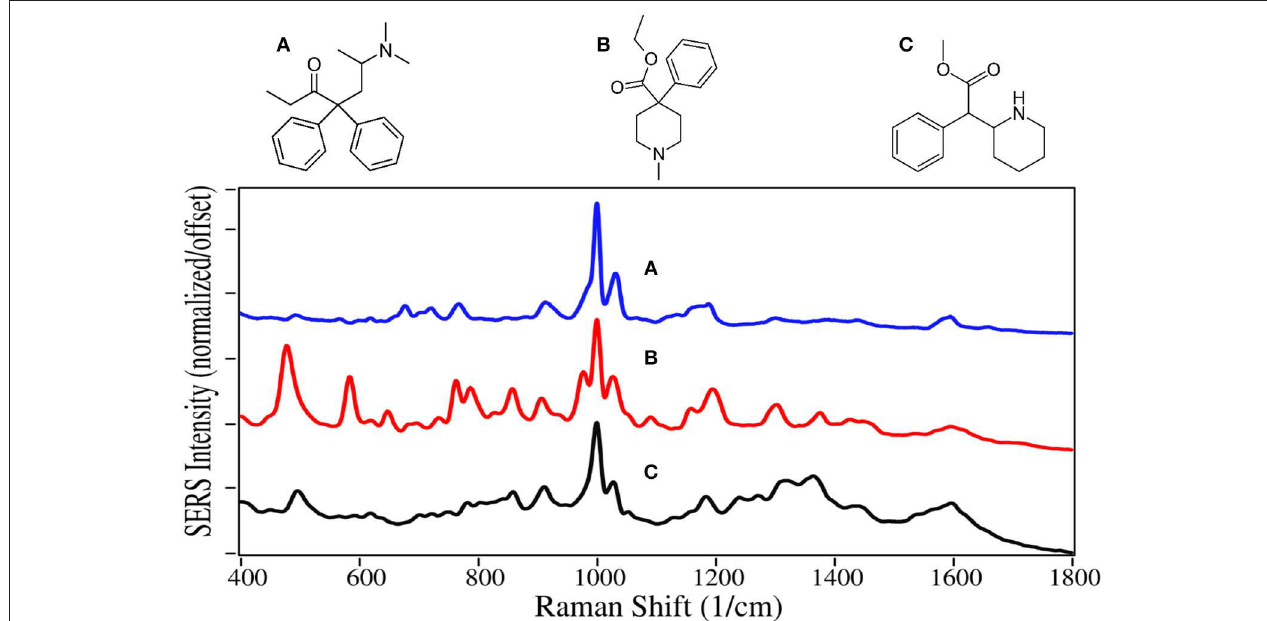
FIGURE 5 | Structures and 100 ppm SERS of (A) methadone, (B) meperidine, and (C)